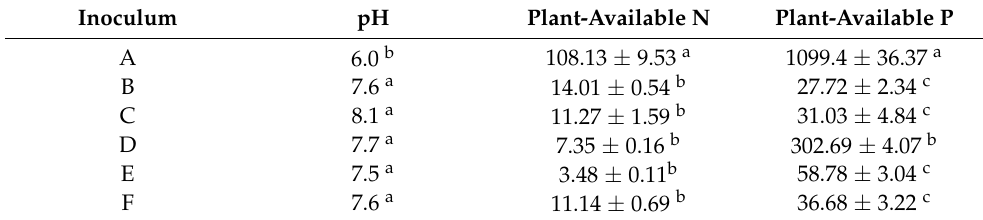
Table 3. Inoculum pH and nutrient characteristics (g kg − 1